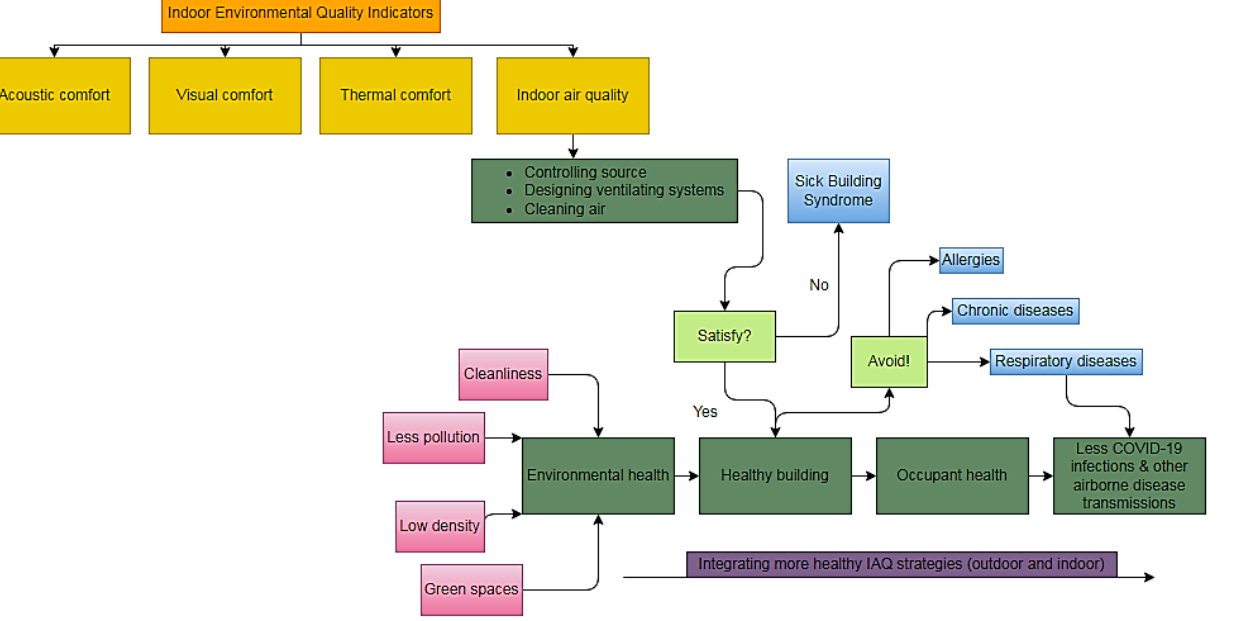
Figure 2. The tangled links between environmental health and projected human health consequences.